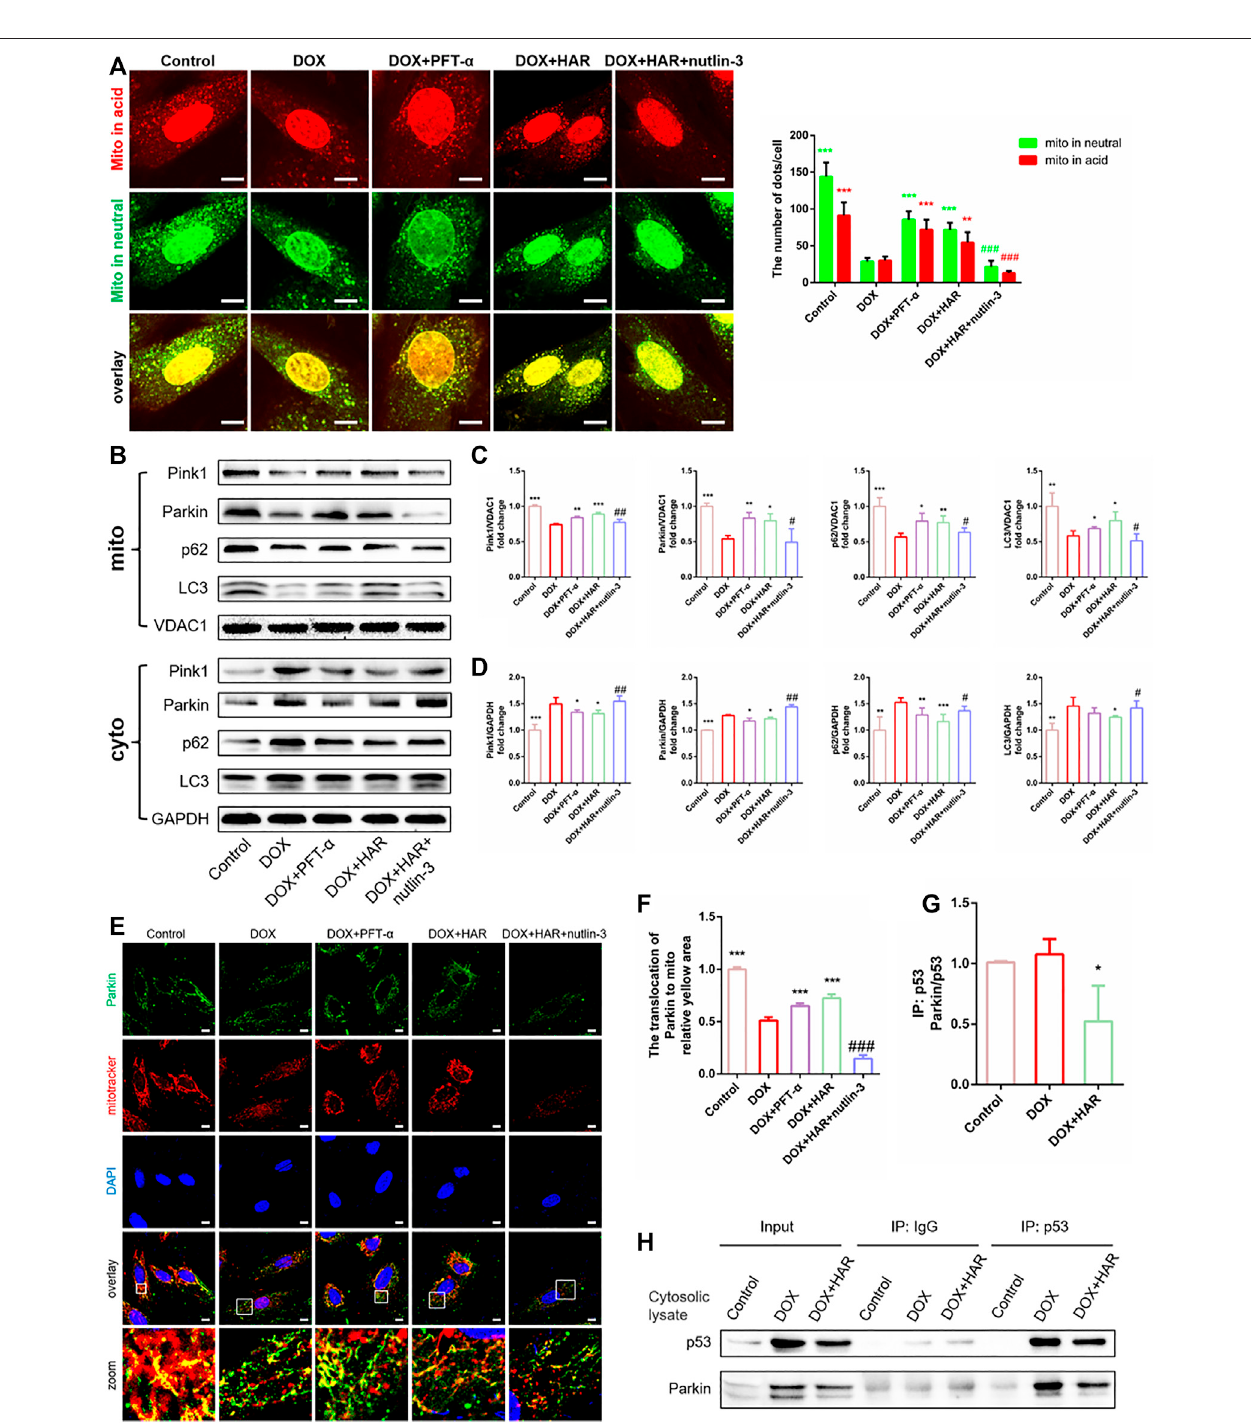
FIGURE 7 | HAR promoted Parkin-mediated mitophagy by inhibiting the binding of cytosolic p53 to Parkin in vitro . (A) Representative confocal images and quantitativeanalysisofmt-Keimapunctaexpressed inH9C2 cellstreated withHAR,PFT- α ornutlin-3 ( n =6). (B – D) p53-dependent mitophagy-related proteins located in the cytosol and mitochondria were determined by immunoblotting, and their relative protein expression levels are shown after normalization to GAPDH or VDAC1( n = 3 – 6). (E,F) Quantitative analysis of Parkin recruited to the mitochondria by costaining for Parkin and MitoTracker ( n = 6). Scale bar: 10 μ m. (G,H) Representative immunoblots and quantitative analysis of the binding of p53 and Parkin in the cytosolic lysates of H9C2 cells. Cytosolic lysates of H9C2 cells were immunoprecipitated with anti-p53 and control IgG antibodies and immunoblotted with anti-Parkin and anti-p53 antibodies. The quantity of Parkin binding with p53 are normalizing to immunoprecipitatedp53( n =3).* p < 0.05,** p < 0.01,*** p < 0.001vs.DOXgroup. # p < 0.05, ## p < 0.01, ### p < 0.001vs.(DOX+HAR)group.Thedataareshownasthe mean ±